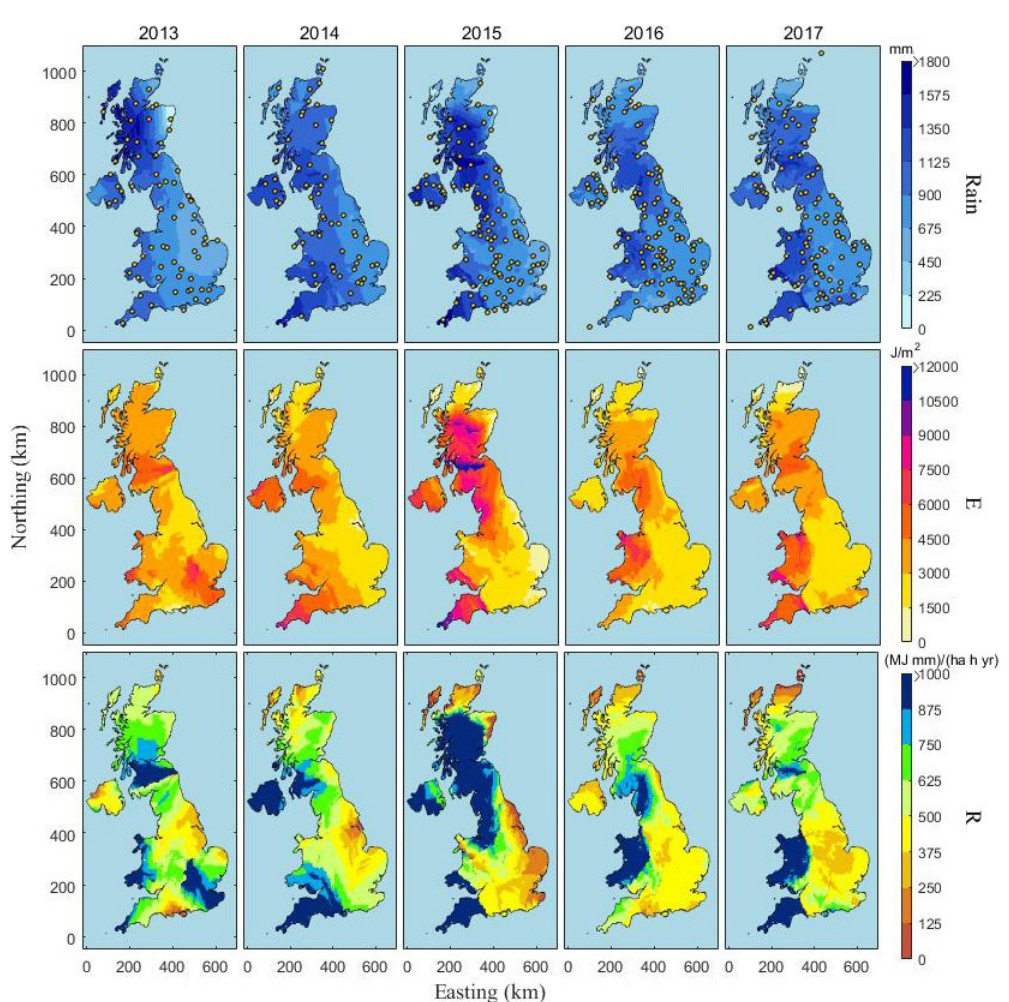
Figure 3. Gauge-based interpolation maps of annual rainfall amount ( Rain ), rainfall kinetic energy ( E ), and rainfall erosivity ( R ) in 2013–